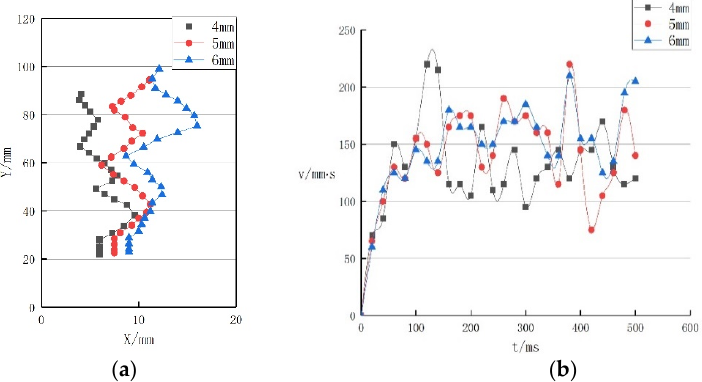
Figure 10. Bubble motion path and rising speed diagram under different diameters: ( a ) Motion path, ( b ) Ascent speed.